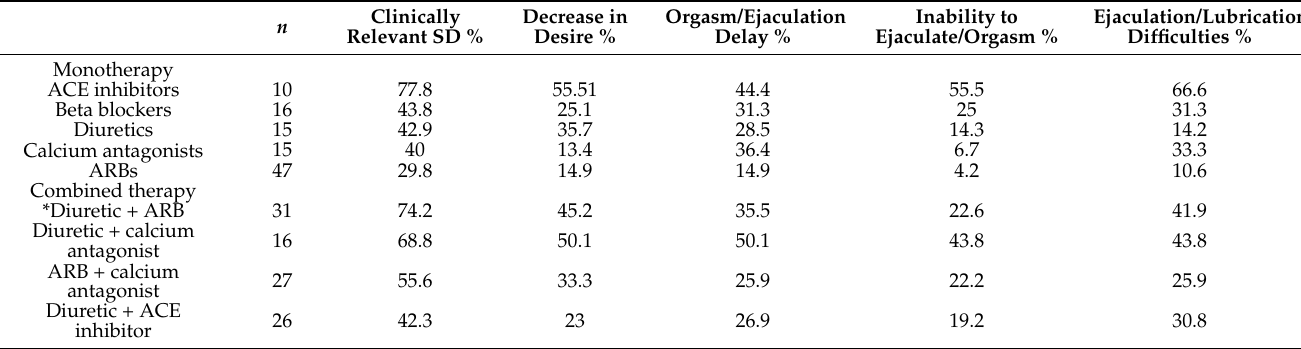
Table 4. Clinically relevant SD and treatments for hypertension.